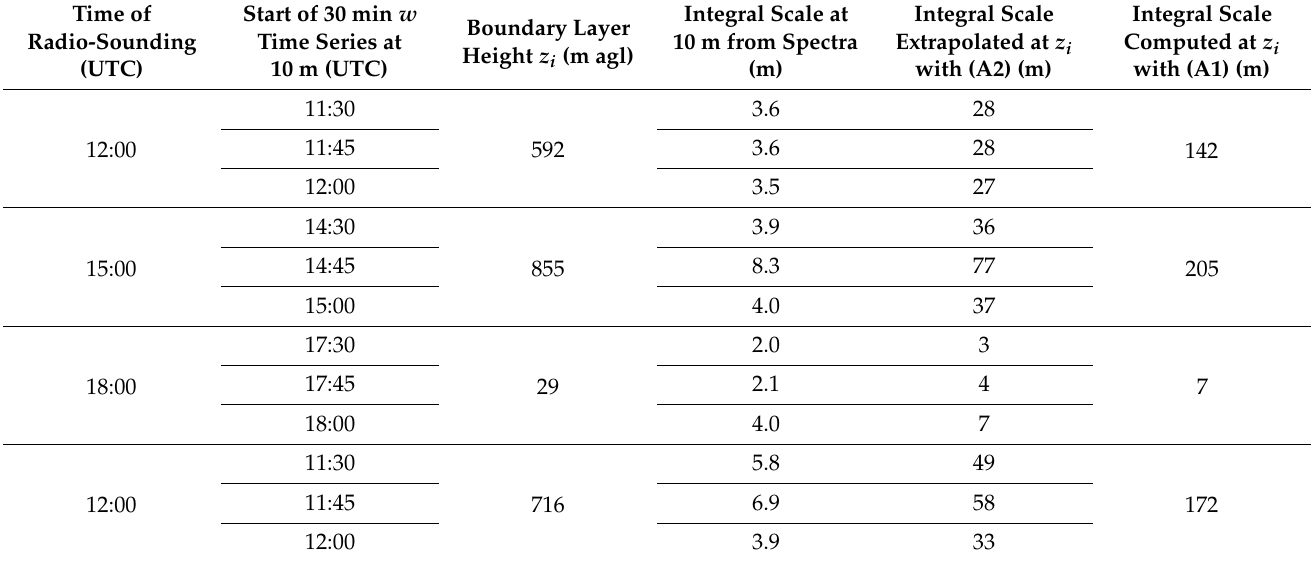
Table A1. From left to right: time of the radiosonde profiles; starting time of the 30 min w time series; ABL thickness estimated from the radiosonde profiles; integral scales computed from w time series at 10 m and extrapolated at z i level; integral scales computed at z i from (A1).